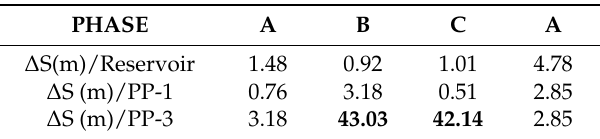
Table 2. Changes in water levels in the reservoir and observation wells PP-1 and PP-3, by operating phase of the